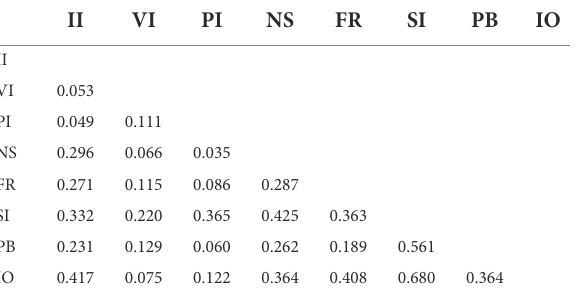
TABLE 4 Heterotrait–monotrait ratio (HTMT)